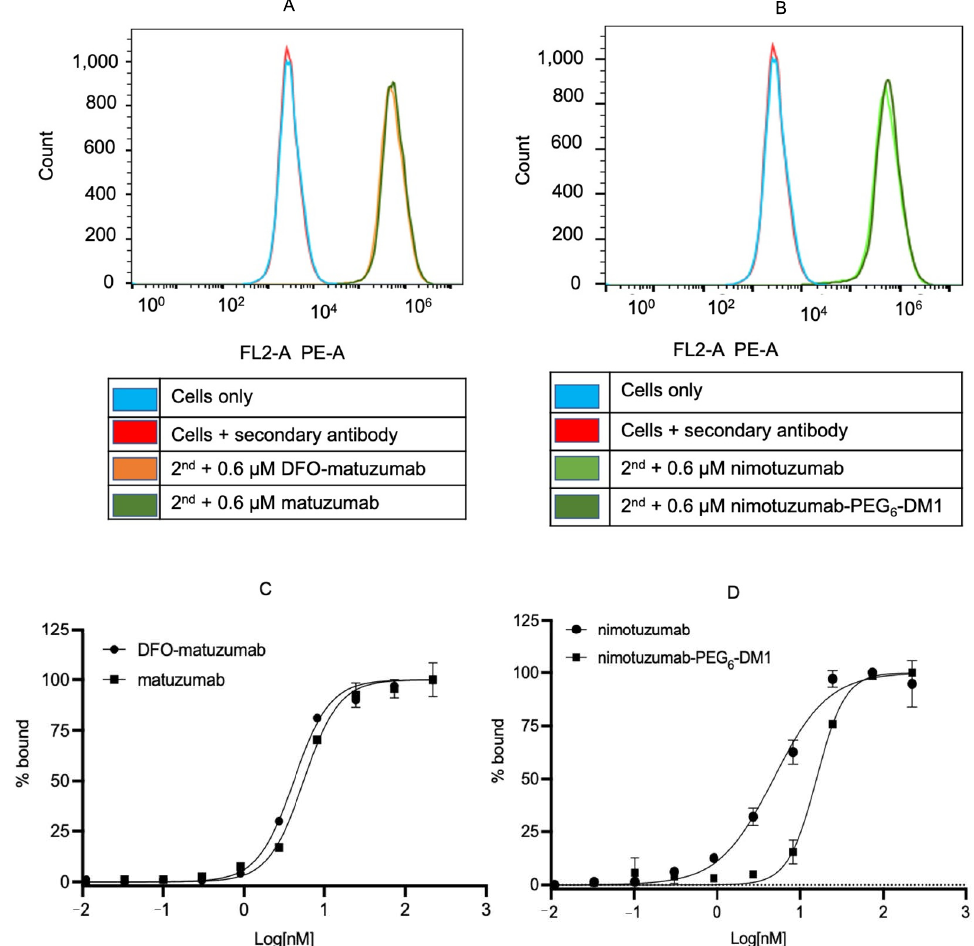
Figure 1. Flow cytometry of immunoconjugates in DLD-1 cells. ( A ) Nimotuzumab and nimotuzumab-PEG 6 -DM1, and ( B ) matuzumab and matuzumab-DFO at 0.6 μ M. Cells with the secondary antibody and untreated cells were used as control. ( C , D ) A 10-point saturation binding that allowed for the determination of K D and EC 50 of the immunoconjugates. The mean fluorescent in- tensity was converted to percentage bound and plotted against concentration, and a nonlinear curve fitting was used to estimate K D and EC 50 . All experiments were carried out in duplicates.